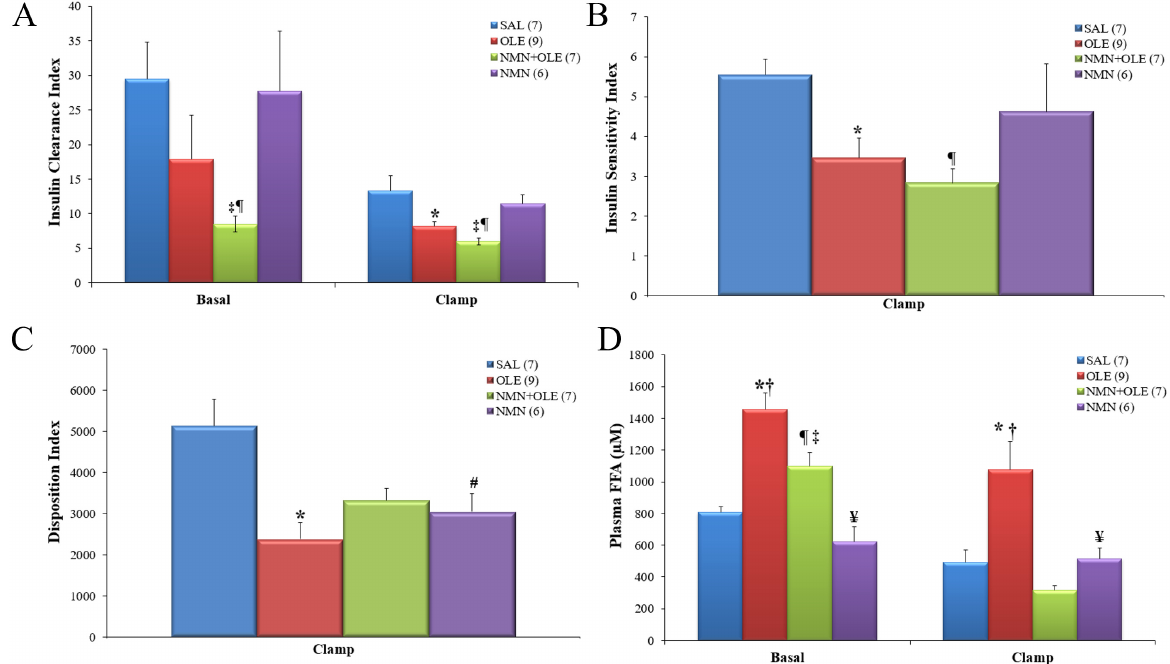
Figure 2. ( A ) Insulin Clearance Index (steady-state C-peptide/insulin molar ratio) prior to intravenous glucose infusion (basal period) and during the last 30 min of the clamp. ( B ) Insulin Sensitivity Index (M/I, μ mol·kg − 1 ·min − 1 glucose per pM insulin) and ( C ) Disposition Index (units = C-peptide in pM multiplied by SI) during the last 30 min of the clamp. ( D ) Plasma FFA levels during the basal period and during the last 30 min of the clamp. C57BL/6J mice were intravenously infused for 48 h with SAL, OLE (0.4 μ mol/min), NMN (0.025 mg·kg − 1 ·min − 1 ) + OLE, or NMN alone. These infusions were maintained during hyperglycemic clamps. Data are means ± SE. Number in parentheses represents number of animals. * p < 0.05, SAL vs. OLE; ¶ p < 0.05, SAL vs. NMN + OLE; # p < 0.05, SAL vs. NMN; † p < 0.05, OLE vs. NMN + OLE; ‡ p < 0.05, NMN + OLE vs. NMN; ¥ p < 0.05, OLE vs. NMN.